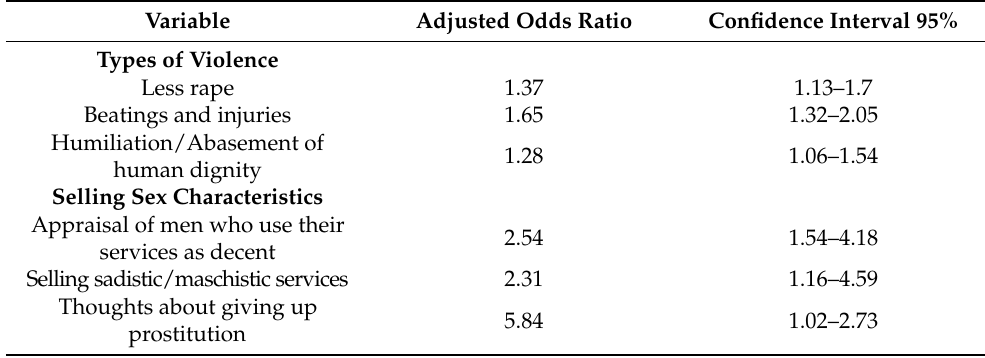
Table 2. Characteristics significantly associated with voluntary or forced appraisal of entering into the commercial sex trade among women selling sex in Saint Petersburg and Orenburg, Russia; multiple logistic regression model ( n =